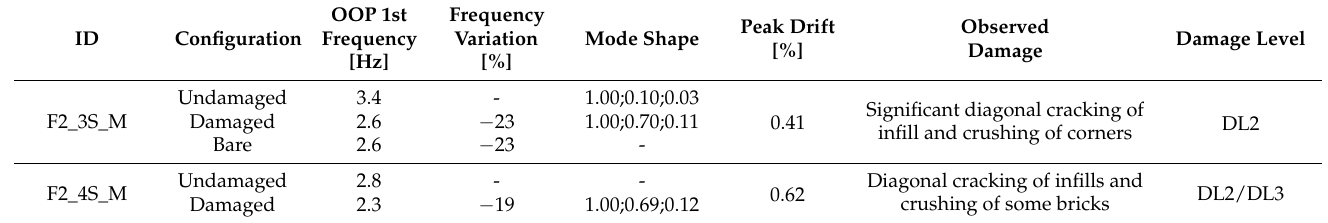
Table 6. Summary of modal identification results via OMA for the first out-of-plane